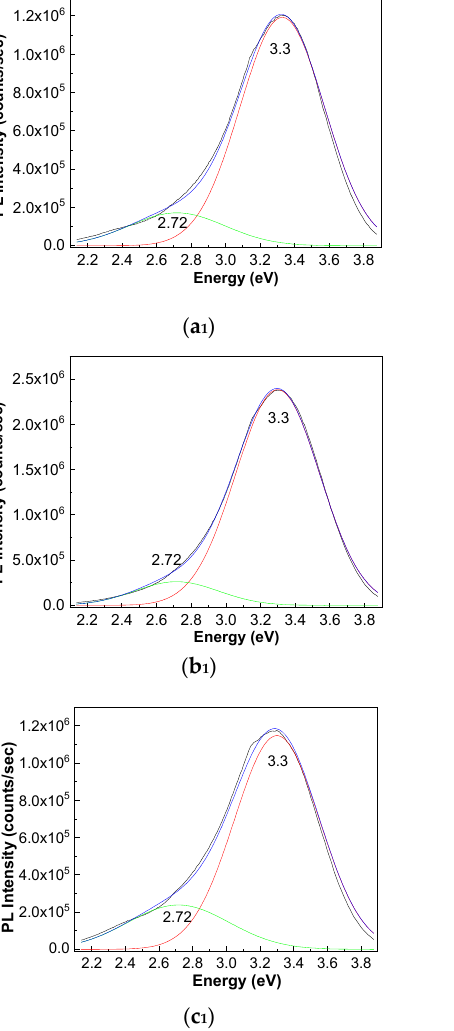
Figure 2. Deconvolution of the PL spectra of the LO drug, in powder state ( a ) and tablet ( b ), before (1) and after the exposure for 187 min. to UV light (2). Figure ( c 1 , c 2 ) show deconvolution of the PL spectra of LO powder storage 5 days in air, before and after 187 min of UV light exposure.